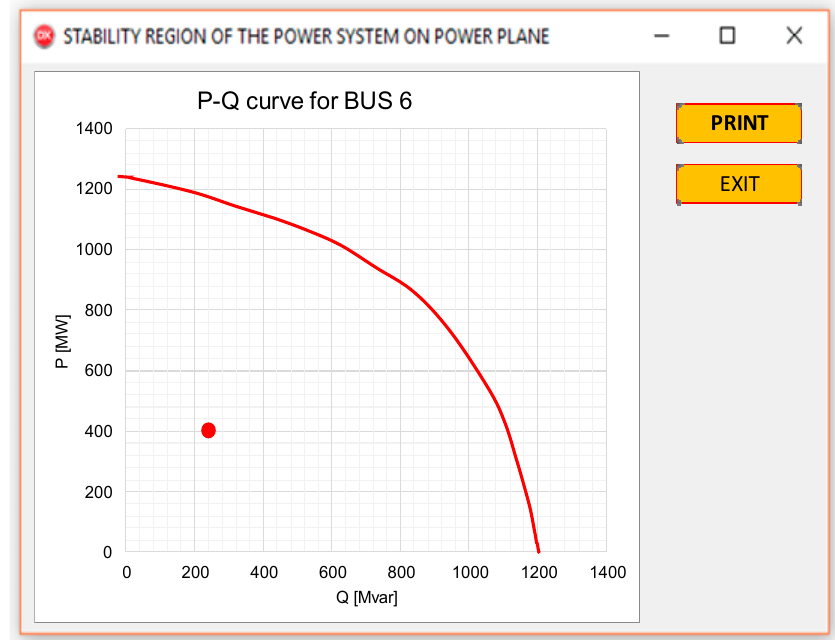
Figure 9. Operating region at Bus 5.